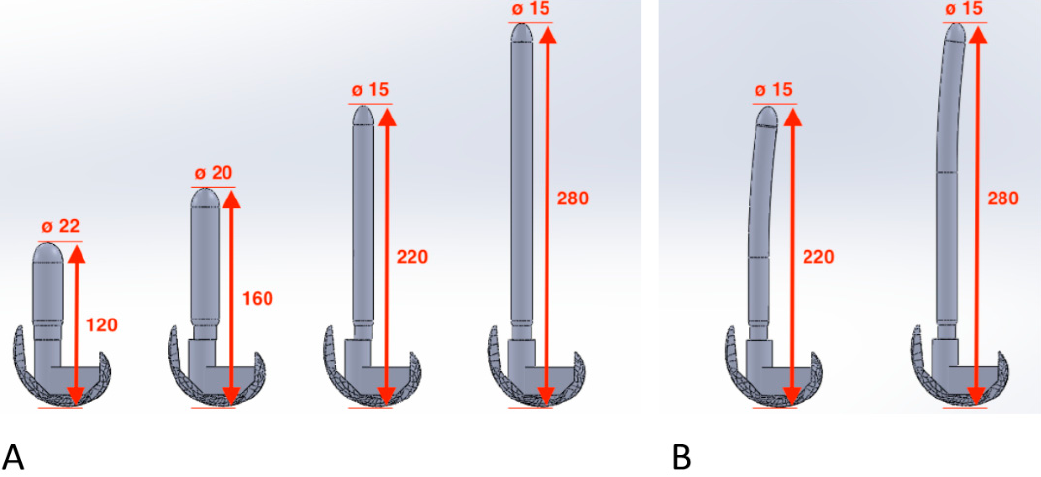
Figure 1. Design of the stems analyzed in the present study with relative length and chosen diameter: ( A ) Straight stems; ( B ) Bowed stems. All the measurements are expressed in mm.